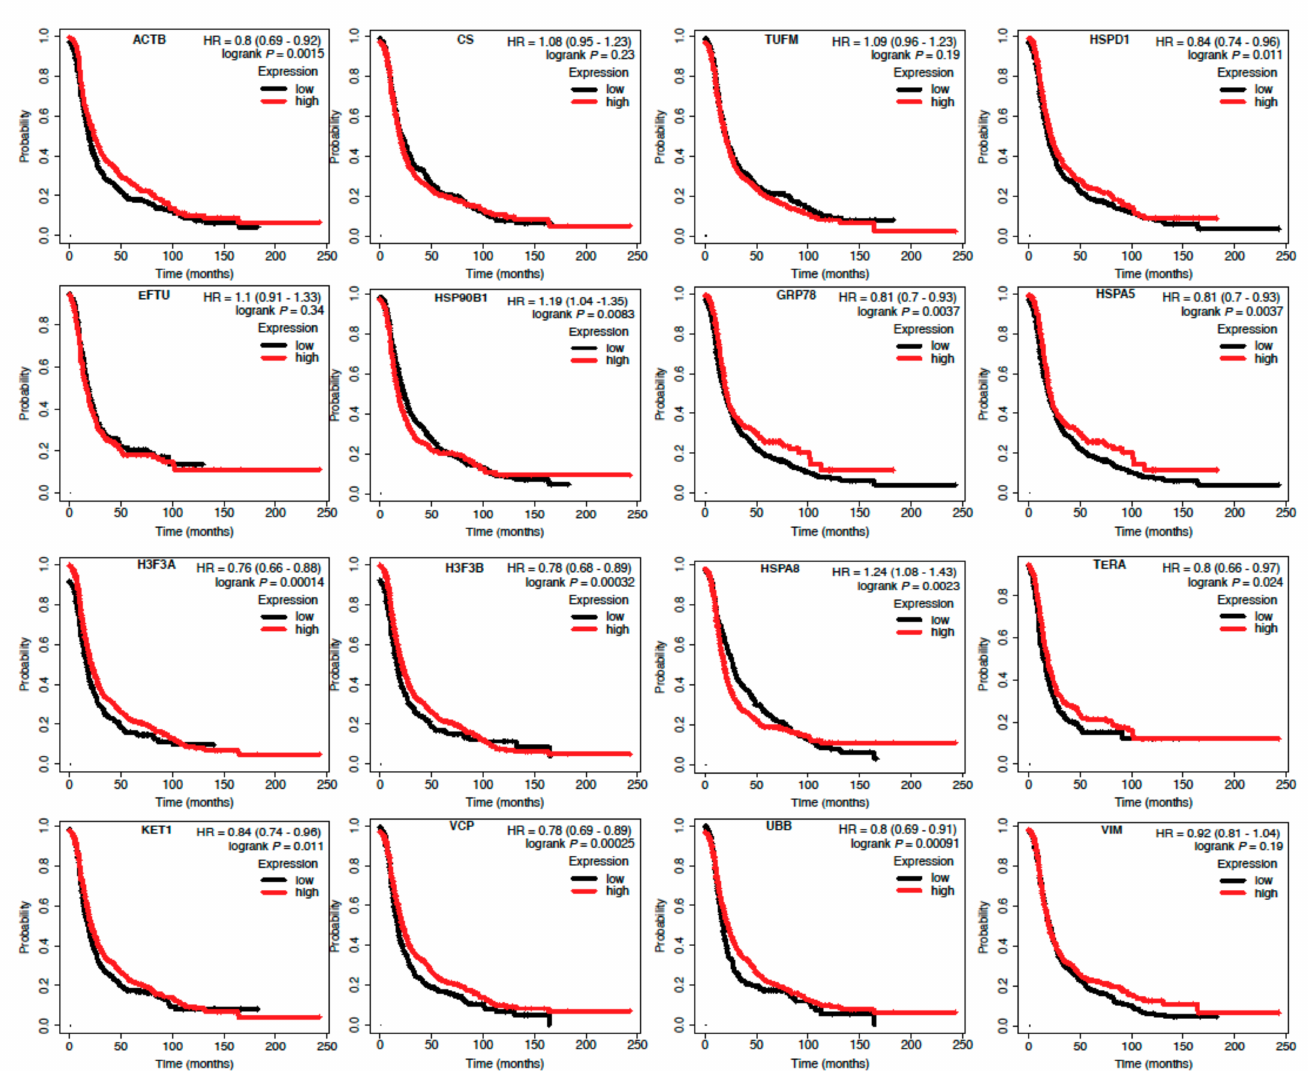
Figure 10. Survival prediction of the 16 genes corresponding to the altered 14 proteins in the ovarian